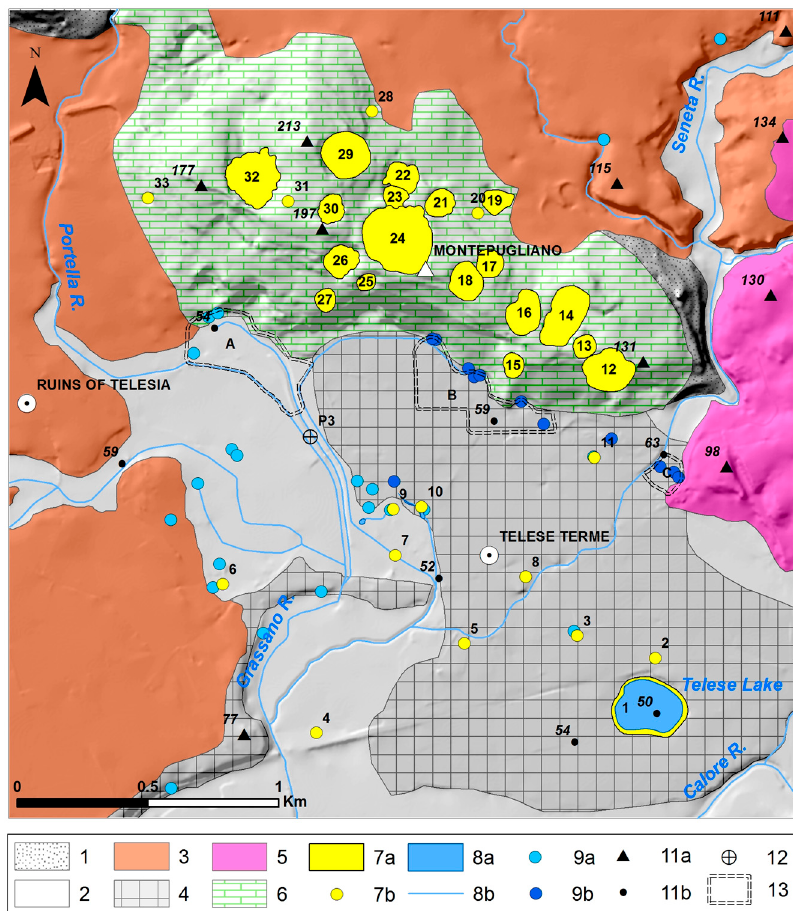
Figure 5. Geological and hydrogeological map of the discharge area of Grassano-Telese springs. (1) Slope deposits; (2) alluvial deposits (Quaternary); (3) Campanian Ignimbrite and pyroclastic deposits; (4) travertine deposits; (5) flysch terrains; (6) limestones and dolostones; (7) main sinkhole (a) and small sinkhole (b); (8) lake (a) and drainage lines (b); (9) cold (a) and sulfurous thermal (b) springs; (11) peak (a) and elevation point (b); (12) borehole; (13) Grassano Park. (A), Terme Minieri Park and (B), Terme Jacobelli Park (C).